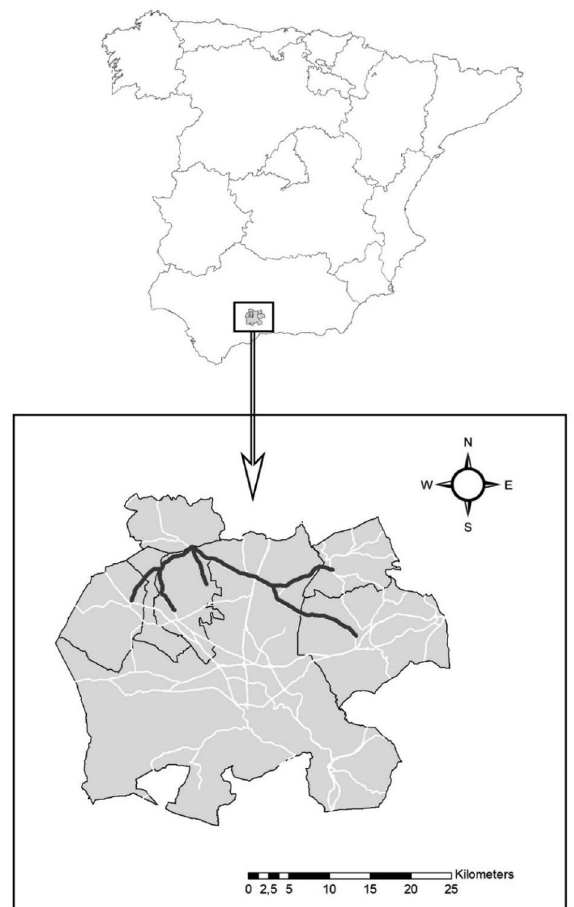
Figure 1. Location of the study area in northeast Malaga province (southern Spain), showing the stretches of road sampled for hare roadkills (thick black lines; 55.7 km) in relation to the total road network in the study area (white lines). Map created with ArcGis 9.3 (ESRI 2008). Datasets from Instituto de Estadística y Cartografía de Andalucía, Junta de Andalucía. Road network and administrative boundaries (https:// www. idean daluc ia. es/ catal